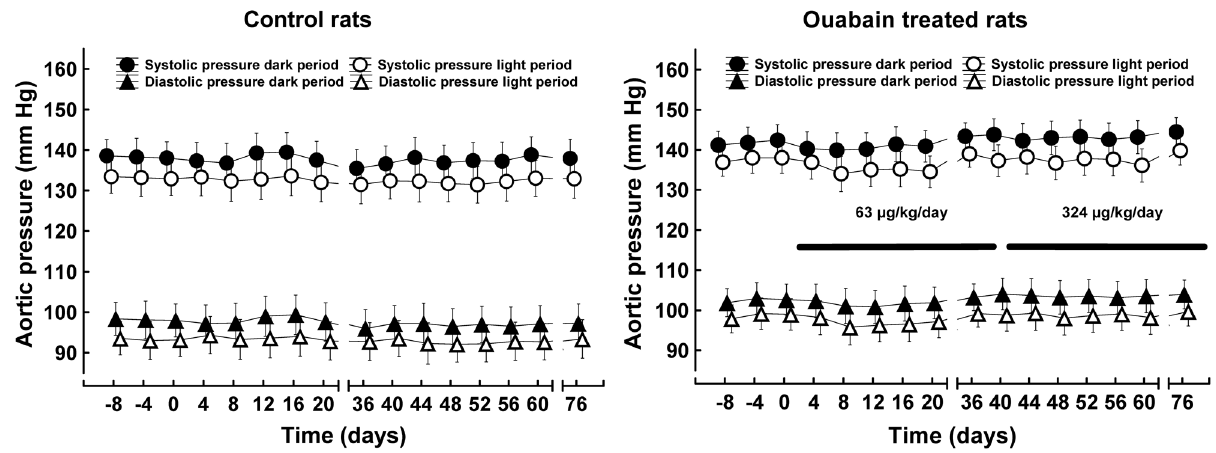
Figure 1. Effect of ouabain on arterial blood pressure. The data points represent the 12-hour means; the vertical bars denote the 95% CIs (confidence intervals). Pharmacological, salt sensitivity, stress and tail-cuff simulation tests were performed during days 20–40 and 60–80. Control rats, n=9; ouabain-treated rats, n=10. Data were analyzed with MANOVA for repeated measures and the multivariate Wilk’s test (between-within design; 2 levels of the main effect ‘‘group’’ x 2 levels of the main effect ‘‘illumination’’ x 16 levels of the main effect ‘‘time/ouabain treatment’’). F, multivariate F-test value, subscripts are degrees of freedom; P, probability. Systolic pressure: main effect ‘‘group’’, i.e., control vs. ouabain group, F 1,17 =1.95, P=0.18; main effect ‘‘time’’ F 15,3 =1.51, P=0.415; main effect ‘‘illumination’’ F 1,17 =143, P , 10 2 6 ; no significant interactions between the main effects were present. Diastolic pressure: main effect ‘‘group’’ F 1,17 =4.39, P=0.052; main effect ‘‘time’’ F 15,3 =5.91, P=0.08; main effect ‘‘illumination’’ F 1,17 =229, P , 10 2 6 ; no significant interactions between the main effects were present.